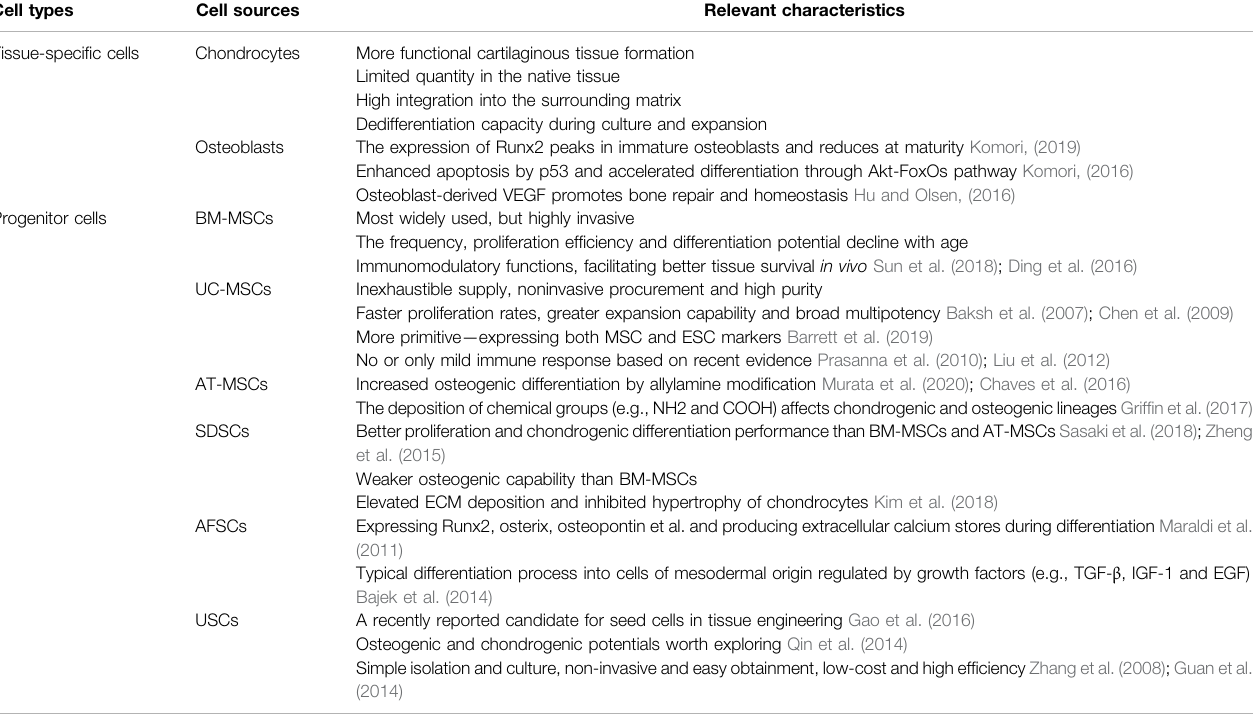
TABLE 1 | Cell resources in osteochondral tissue engineering.